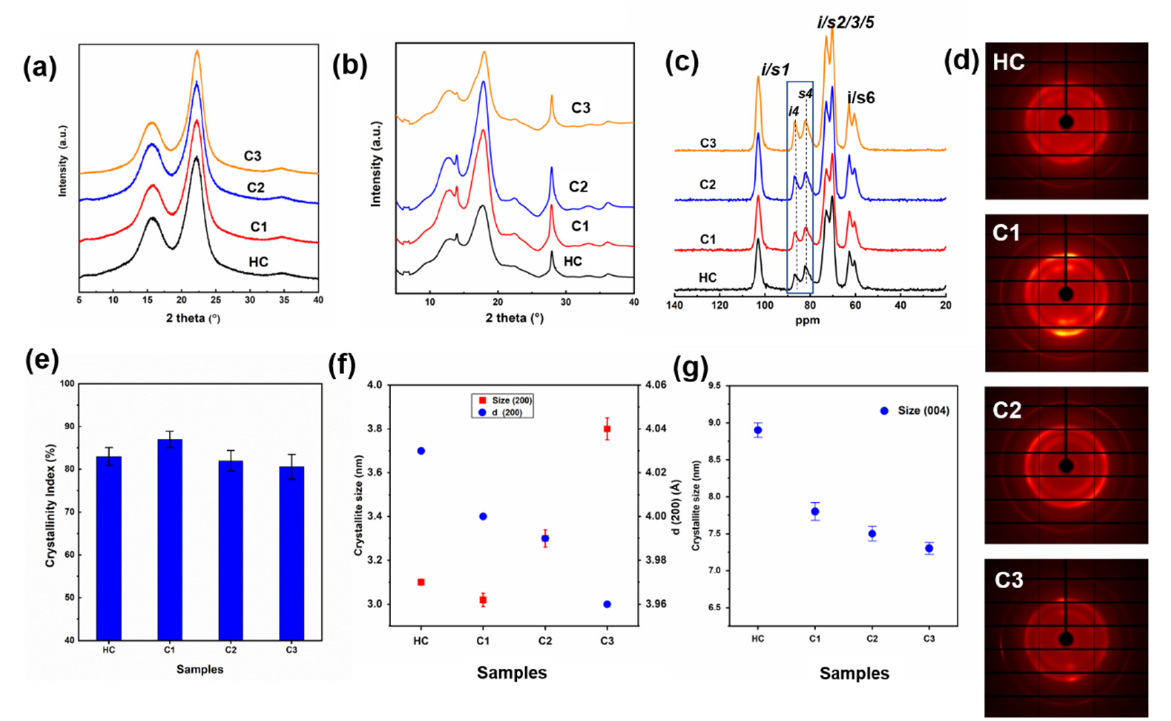
Figure 3. One-dimensional XRD ( a )/WAXS ( b ) patterns, 13 C NMR spectra ( c ), and the two-dimensional ( d ) images of the holocellulose before and after HTP (C1, C2 and C3); calculated CrI ( e ), crystallite sizes, and d-spacings ( f , g ) perpendicular to different lattice planes.